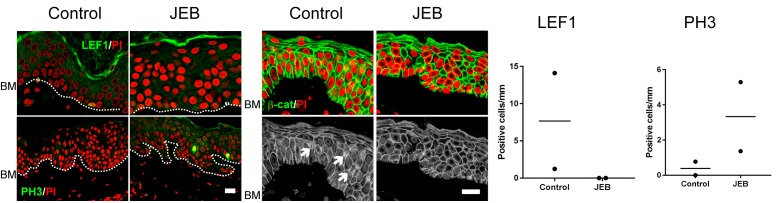
Wnt signaling and proliferation profile in JEB patients epidermis with COL17 deficiency.LEF1, β-catenin and PH3 labeling of skin specimens from two JEB patients and controls. LEF1-positive cells and nuclear β-catenin accumulation are indicated with arrows. Scale bar: 20 μm. Quantification of LEF1- and PH3-positive basal cells per mm epidermis.